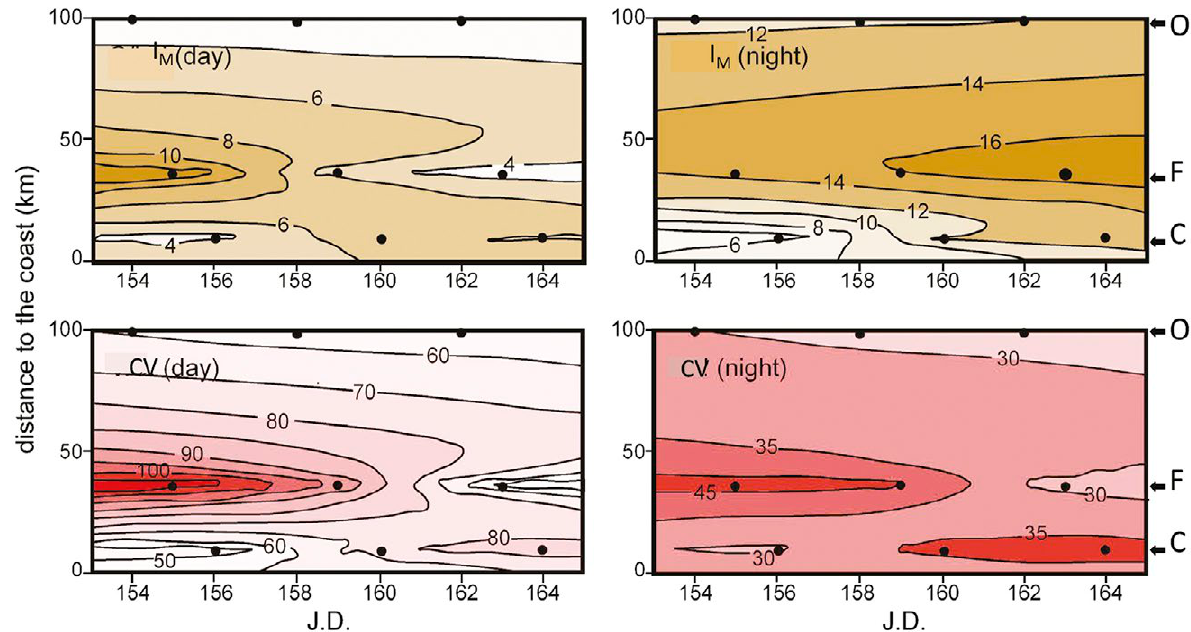
) and individual size (I ) and their variability (CV) for day and night samples. Horizontal and ZOO M vertical axes as in Figure